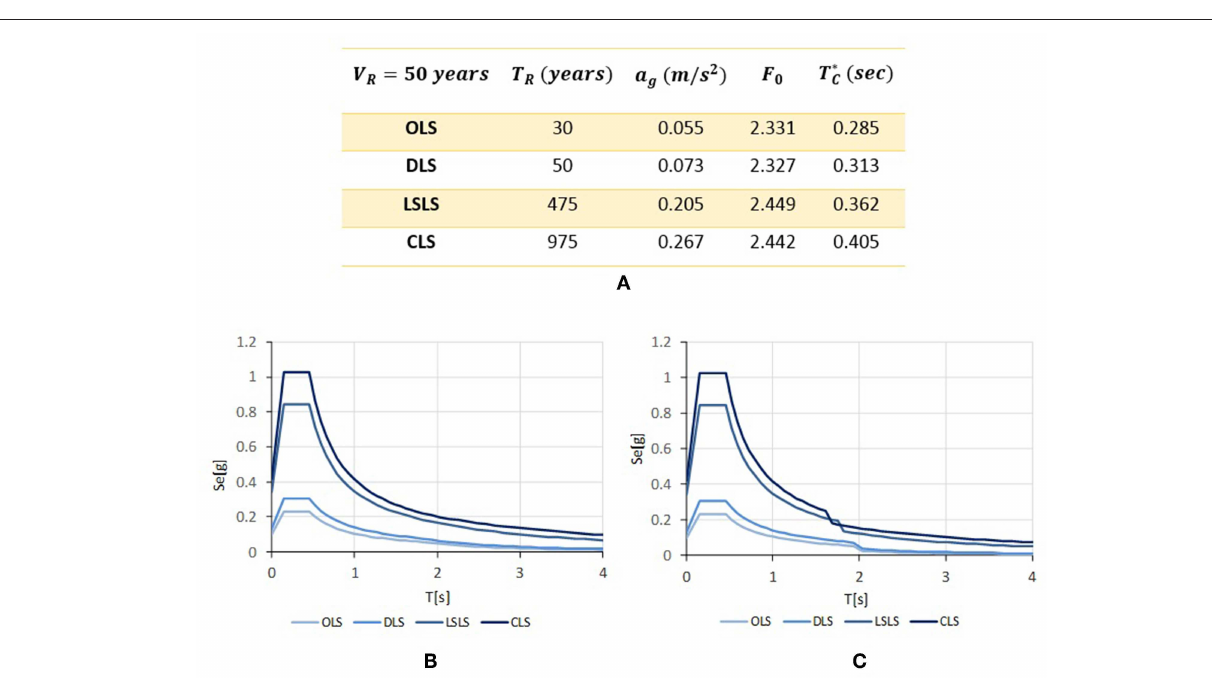
FIGURE 5 | Site seismic hazard and response spectra considered. (A) Parameters defining the seismic action referred to a rigid soil (Type A) for each limit state. (B) Elastic response spectra ( ξ = 5%) for a soil Type C. (C) Design spectra for isolated system for a soil type